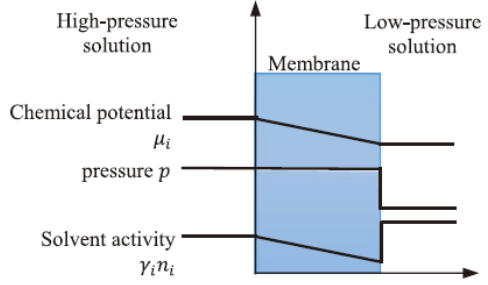
Figure 6. The pressure variation in the gas permeation process [41].